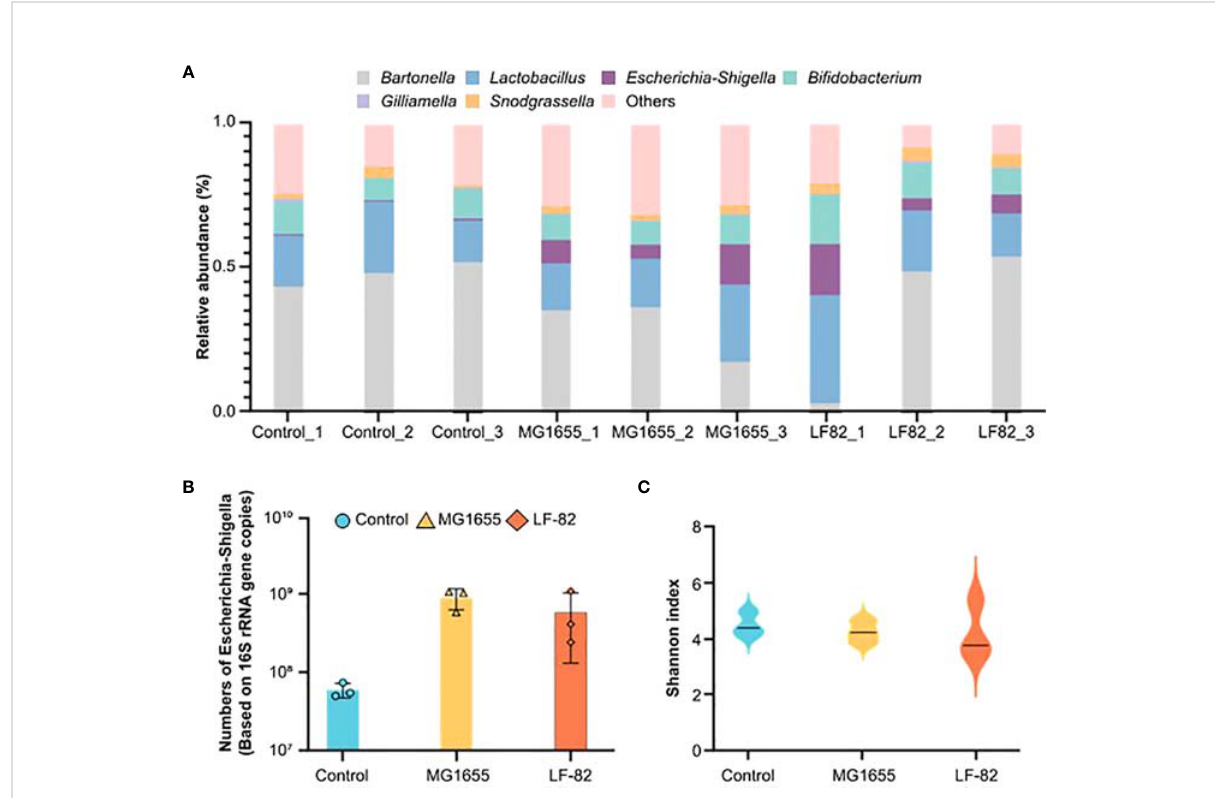
FIGURE 3 LF82 and MG1655 have no effect on the honeybee gut microbial diversity. (A) Relative abundance of core bacteria in the gut of honeybees in the different groups (n = 3). (B) Contents of Escherichia coli in the gut of honeybees in the three groups (n = 3). (C) a -diversity in the different groups ( p >